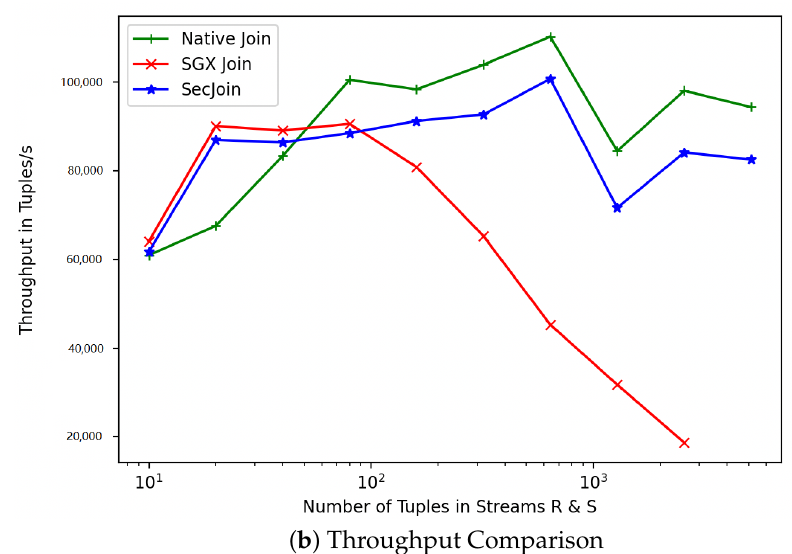
Figure 8. Performance Evaluation of SecJoin Compared to Native and SGX Joins.